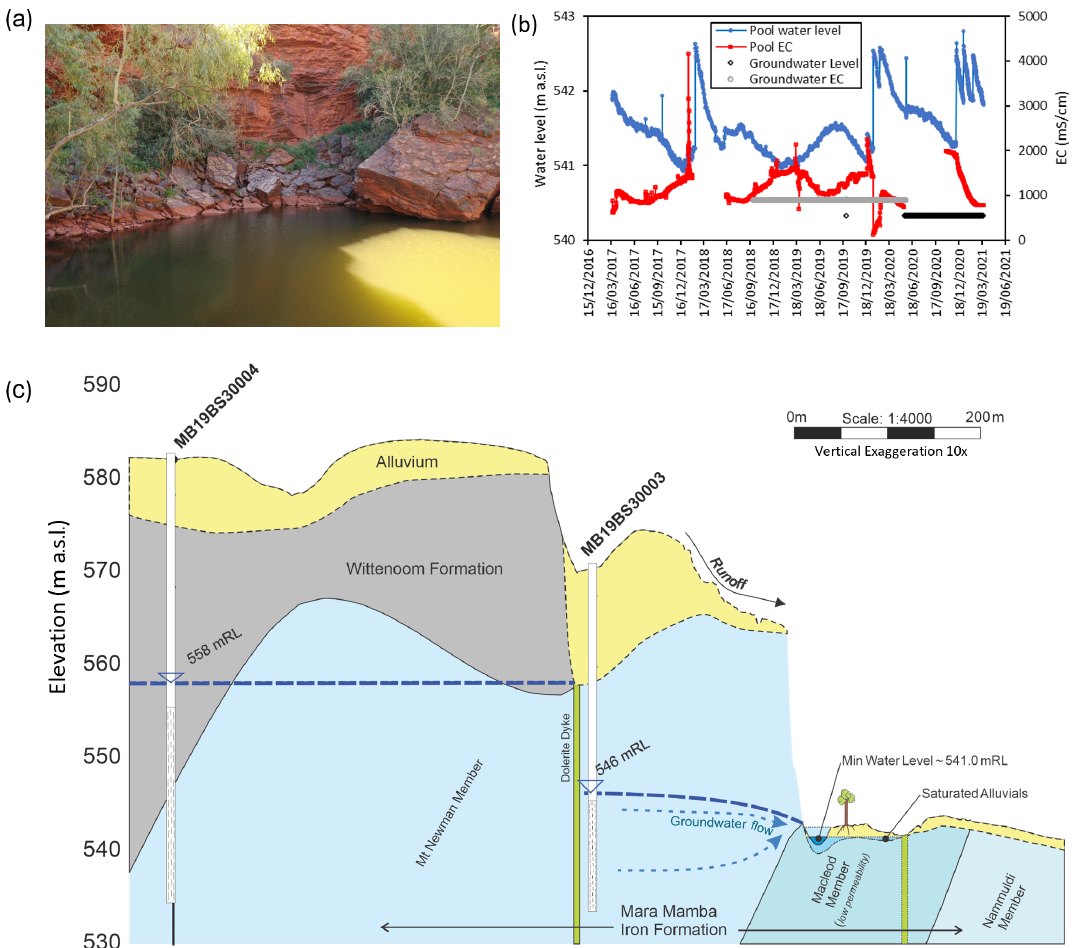
Figure 10. (a) Photo of Plunge Pool, (b) pool water level and electrical conductivity (EC), and (c) hydrogeological setting of the